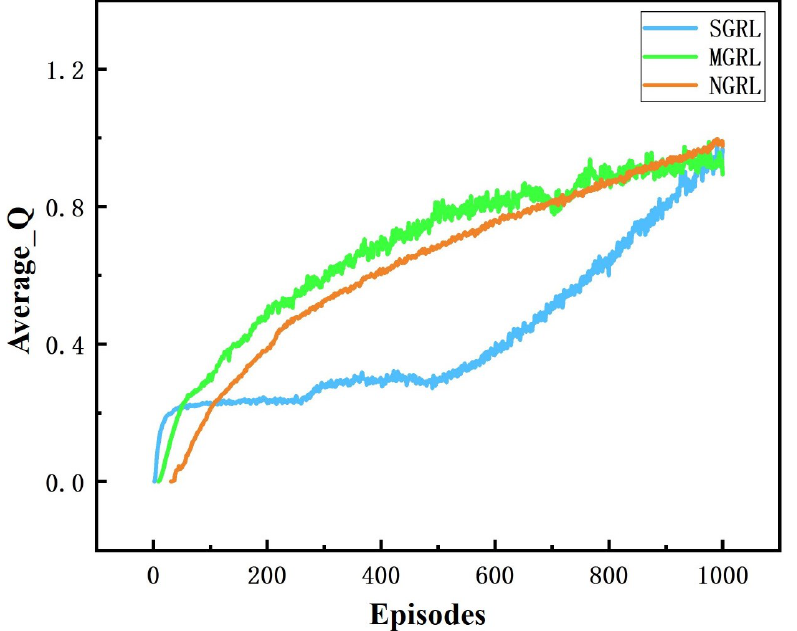
Figure 12. Diagram of average Q. This value is a training mark value in reinforcement